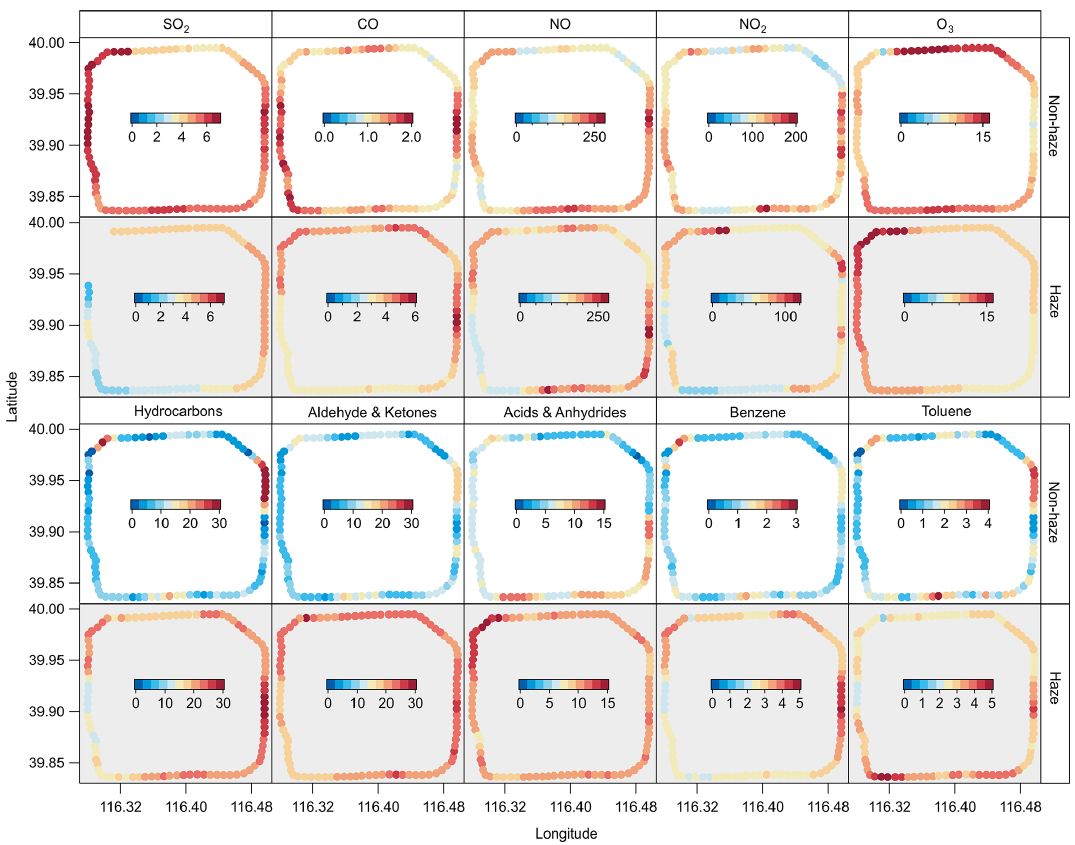
Figure 2. Spatial patterns of the mean mass mixing ratios (units: ppmv for CO and ppbv for others) of gas pollutants measured on the 4th Ring Road in Beijing. Data covered from 09:00 to 16:00 during the measurement period.